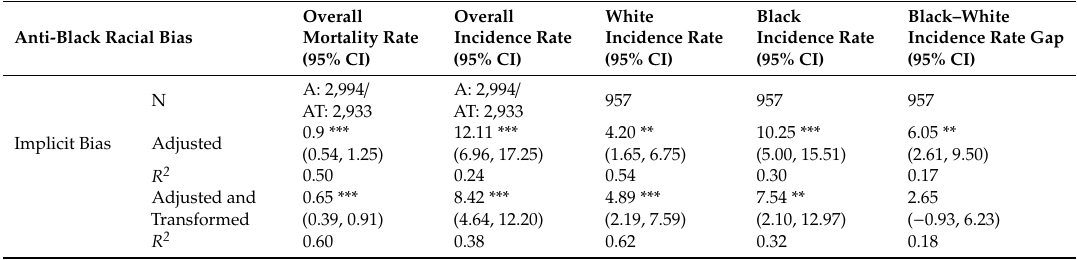
Table 2. Associations of implicit and explicit racial bias with COVID-19 rates per 10,000 individuals in the county using standardized coe ffi cients: adjusted for confounders (Adjusted) or adjusted for confounders with relevant transformations and interactions (Adjusted and